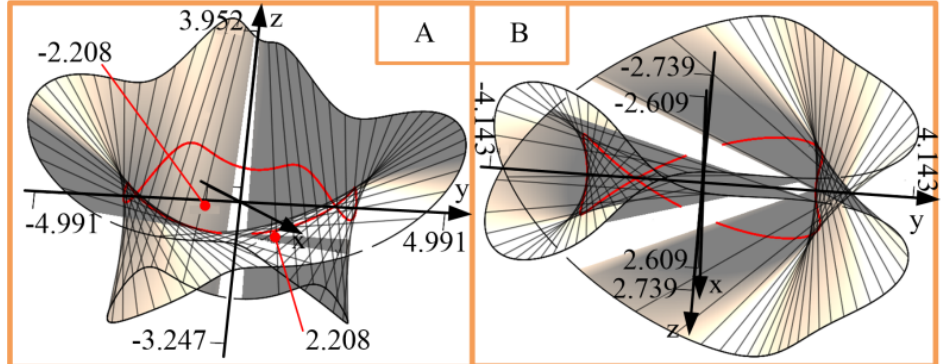
Figure 13. Varying − pitch ruled surface. Figure 13. Varying-pitch ruled surface.